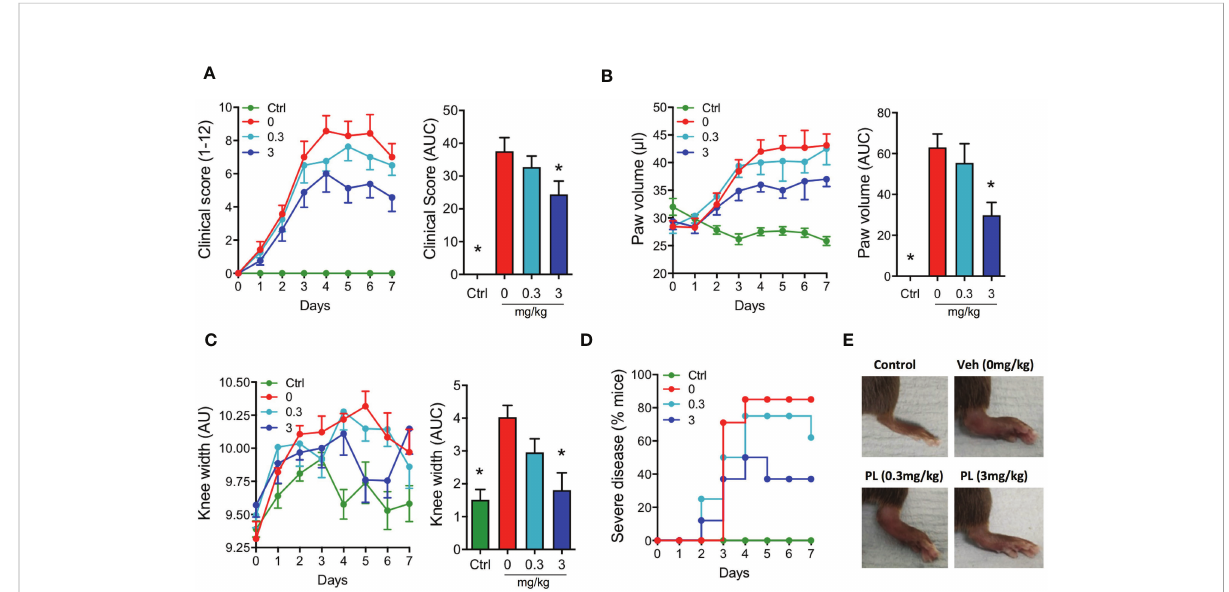
FIGURE 5 Effects of PL8177 in the K/BxN serum transfer induced arthritis (STIA) model Arthritis was induced by injecting mice with 100 m l of K/BxN serum at days 0 and 2. A group of mice that did not receive serum was used as control (Ctrl). Mice were treated daily with vehicle (0mg/kg) or with PL8177 (0.3 or 3mg/kg) from day 2 to 7. Daily measurements of clinical score (A) , paw volume (B) and knee width (C) are shown, together with the quanti fi cation of the area under the curve (AUC) calculated from days 2-7, corresponding to the duration of the treatments (bar graphs). (D) The percentage of mice developing moderate-severe arthritis (score ≥ 6) is presented. Representative images of the hind paws at day 7 are shown in (E) Data represent mean ± SEM of n=6-8 mice analysed by one-way ANOVA followed by multiple comparison test. * p <0.05 vs. vehicle group